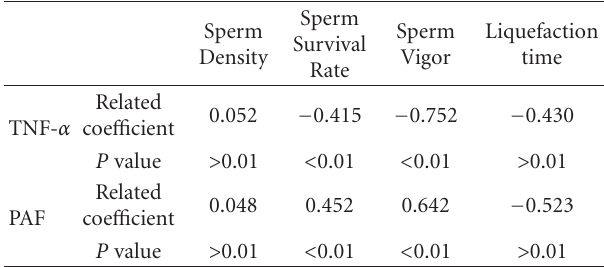
Table 3: Correlation between PAF, TNF- α , and main seminal plasma parameters of leukocytospermia